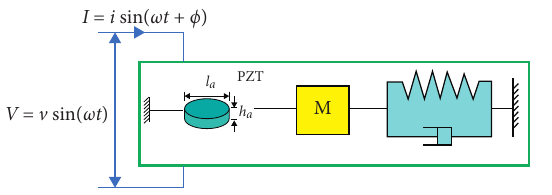
Figure 1: The one-dimensional electromechanical impedance PZT-structure coupling